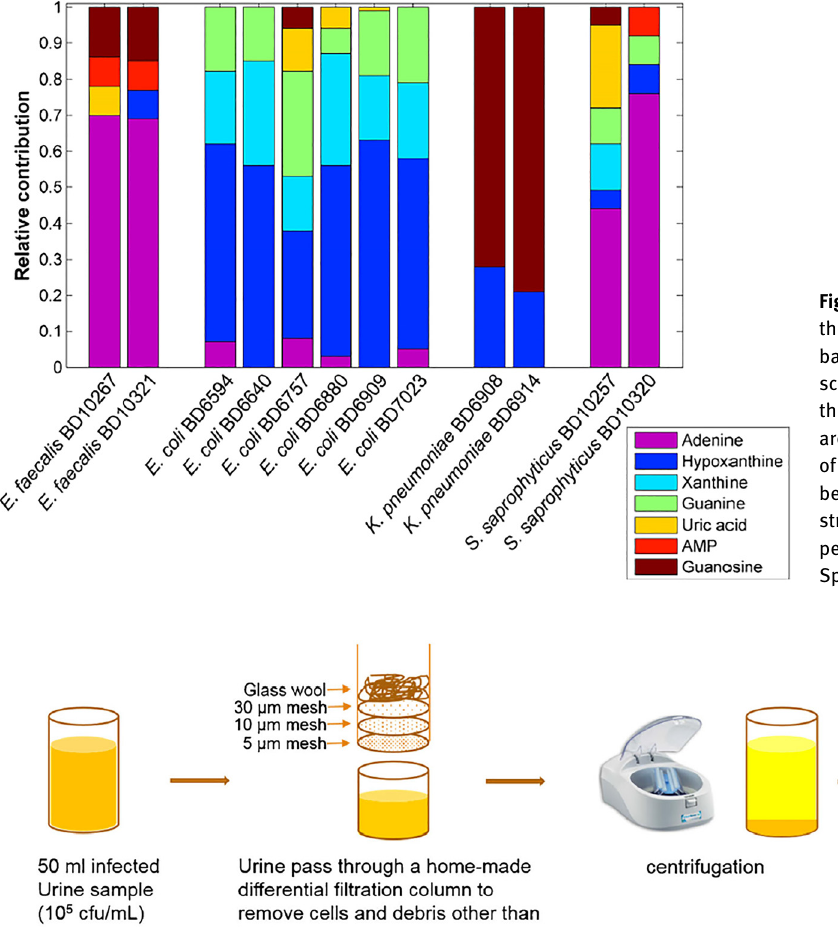
Figure9: A summaryofthesamplepreparationprocedurefortheacquisitionof asurfaceenhancedRamanscattering(SERS)spectrumfroma human urine sample spiked with 10 5 cfu/mL bacteria. A four-stage gravitation fi ltration system (glass wool and sequential 30-, 10-, and 5-um pore size nylon fi lters) removed nonbacterial solid materials followed by centrifugation to achieve enrichment. The entire procedure took ∼ 50 min. Reprinted by permission from Premasiri et al. [62]: Springer Nature, Copyright